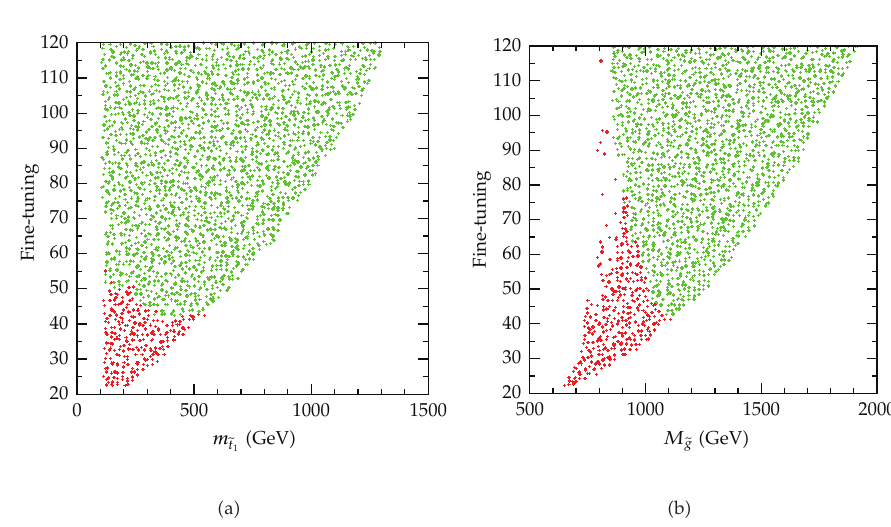
(cid:2) a (cid:3) and M (cid:2) (cid:2) b (cid:3) . The color code is as in Figure g t 1